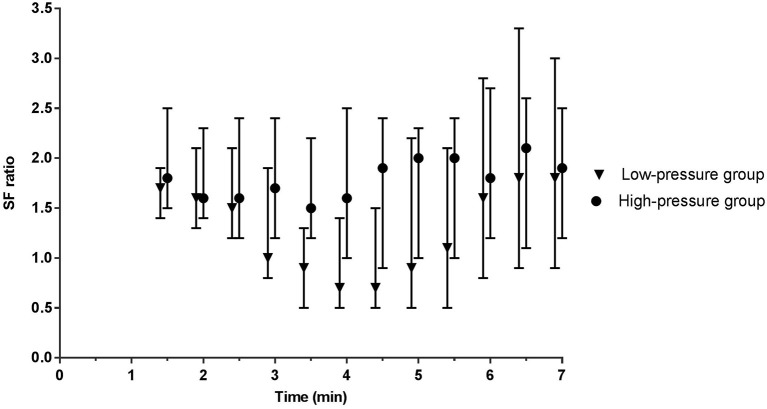
SF ratio. The SF ratio (SpO2/FiO2) represents gas exchange over the lungs and corrects the SpO2 for the given FiO2. Data is presented as median (IQR). At 1.5 and 2 min, the mean of the high-pressure group is calculated based on n = 9 and n = 16, respectively. All other presented data is based on n ≥ 20.